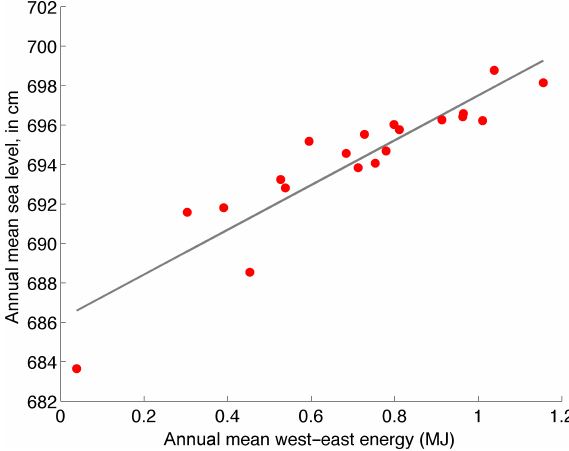
Figure 7. Annual mean sea level versus the annual mean west–east energy component; the correlation is R = 0 . 92. The least squares fit is shown as the grey line.